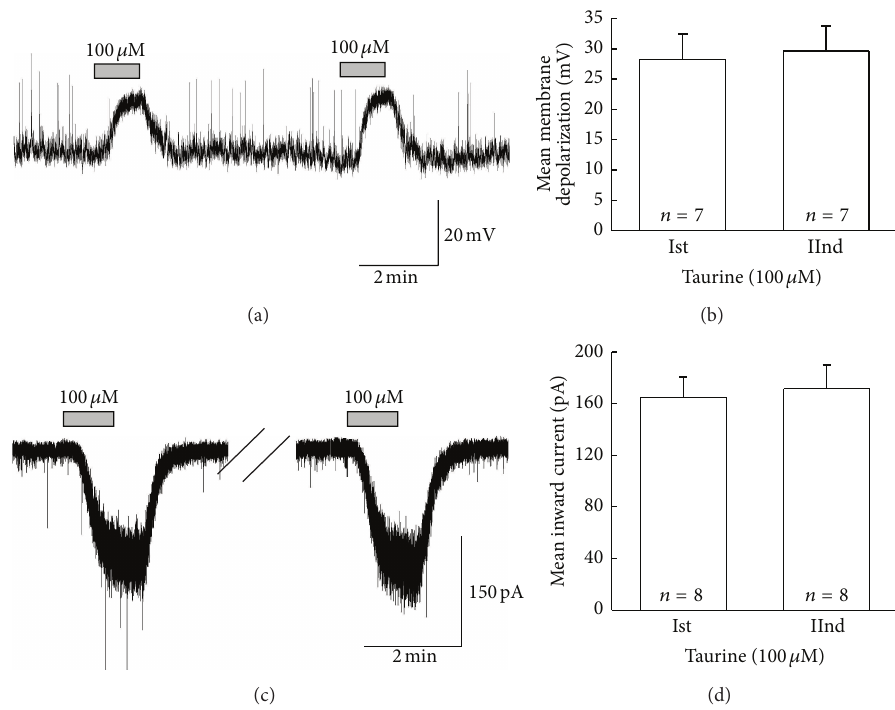
Figure 1: Repeated responses by the successive application of taurine on SG neurons. (a), (c) The representative traces show the repeatable membrane depolarization and repeated inward current induced by taurine (100 𝜇 M). (b), (d) Bar graphs illustrate the comparison of the mean membrane potential and inward current changes by the repeated application of taurine (100 𝜇 M) ( 𝑃 > 0.05